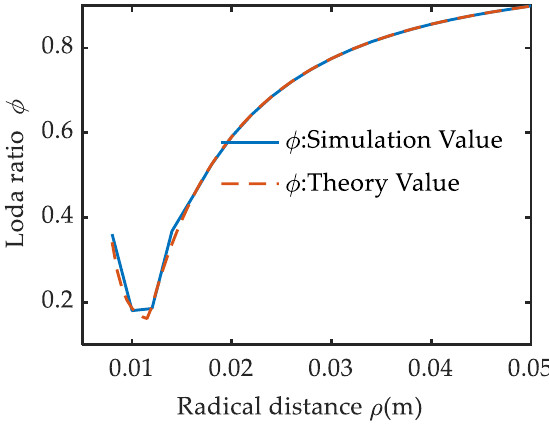
Figure 12. Load ratio comparison between the theory and the ADMAS.